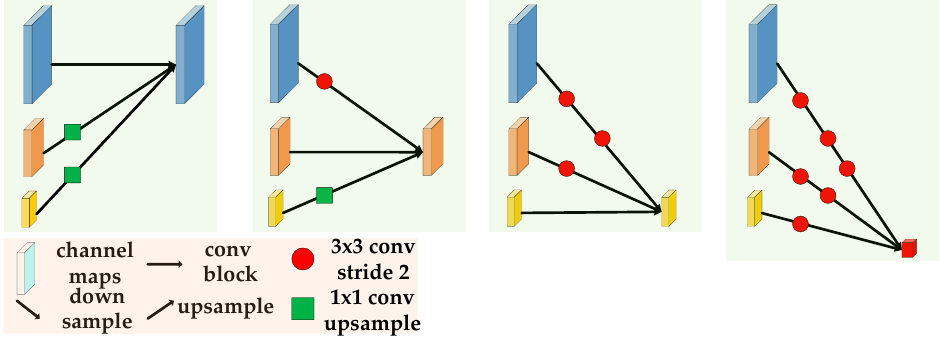
Figure 5. Multi-resolution representations information exchange. The left to right graphs is the fusion of the four resolutions from high to low. The red circle indicates the 3 × 3 convolution of stride 2 and the green box indicates bilinear up-sampling followed by a 1 × 1 convolution.